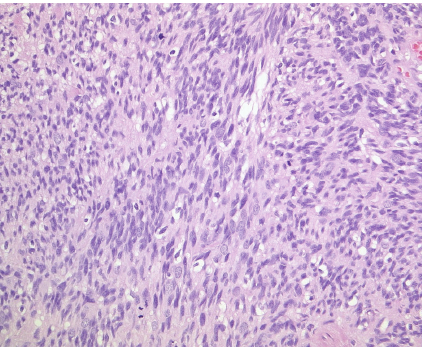
Figure 2: A patternless, highly cellular lesion is seen with increased mitotic activity (H&E, × 200, original magnification).